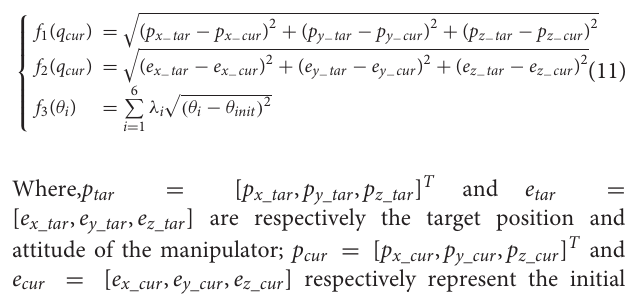
of position accuracy, posture accuracy, and joint angle can be